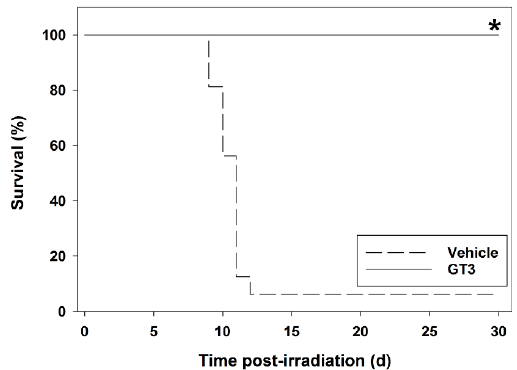
Figure 2. Radioprotective efficacy of subcutaneously-administered γ -tocotrienol (GT3) in irradiated CD2F1 strain male mice. Two groups of mice were administered either GT3 (200 mg/kg) or vehicle subcutaneously 24 h prior to whole body irradiation with 9.2 Gray (Gy) (dose rate 0.6 Gy/min). Mice were observed for 30 days. Mice treated with GT3 had a significantly higher survivor rate compared to the vehicle control group ( n = 16 each group). * Denotes significant difference between the GT3 and vehicle control groups ( p < 0.05) [70].